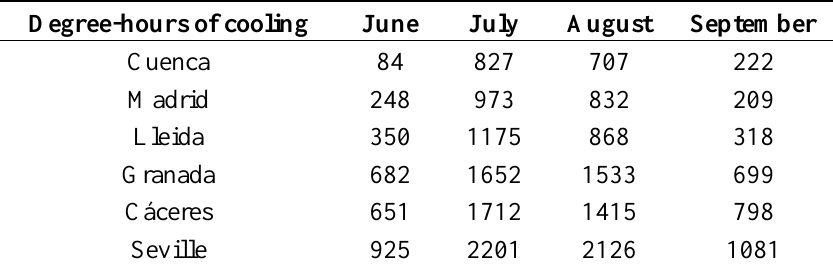
Table 5. Degree-hours of cooling in selected